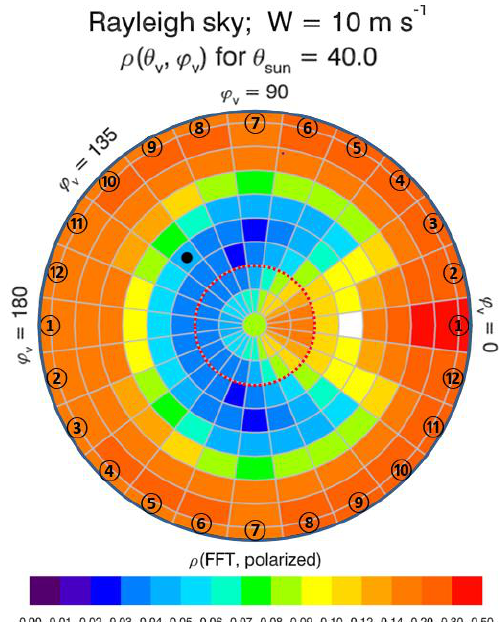
Figure 8 . Surface radiance reflection ( 𝜌 ) as a function of off- nadir and azimuthal viewing directions (relative to the sun’s azimuth at 𝜑 𝑣 = 0 ) for a single sun zenith angle of 𝜃 0 = 40 ⁰ , computed using FFT surface and polarized ray tracing with a Rayleigh sky and a wind speed of 10 m s -1 (Mobley,